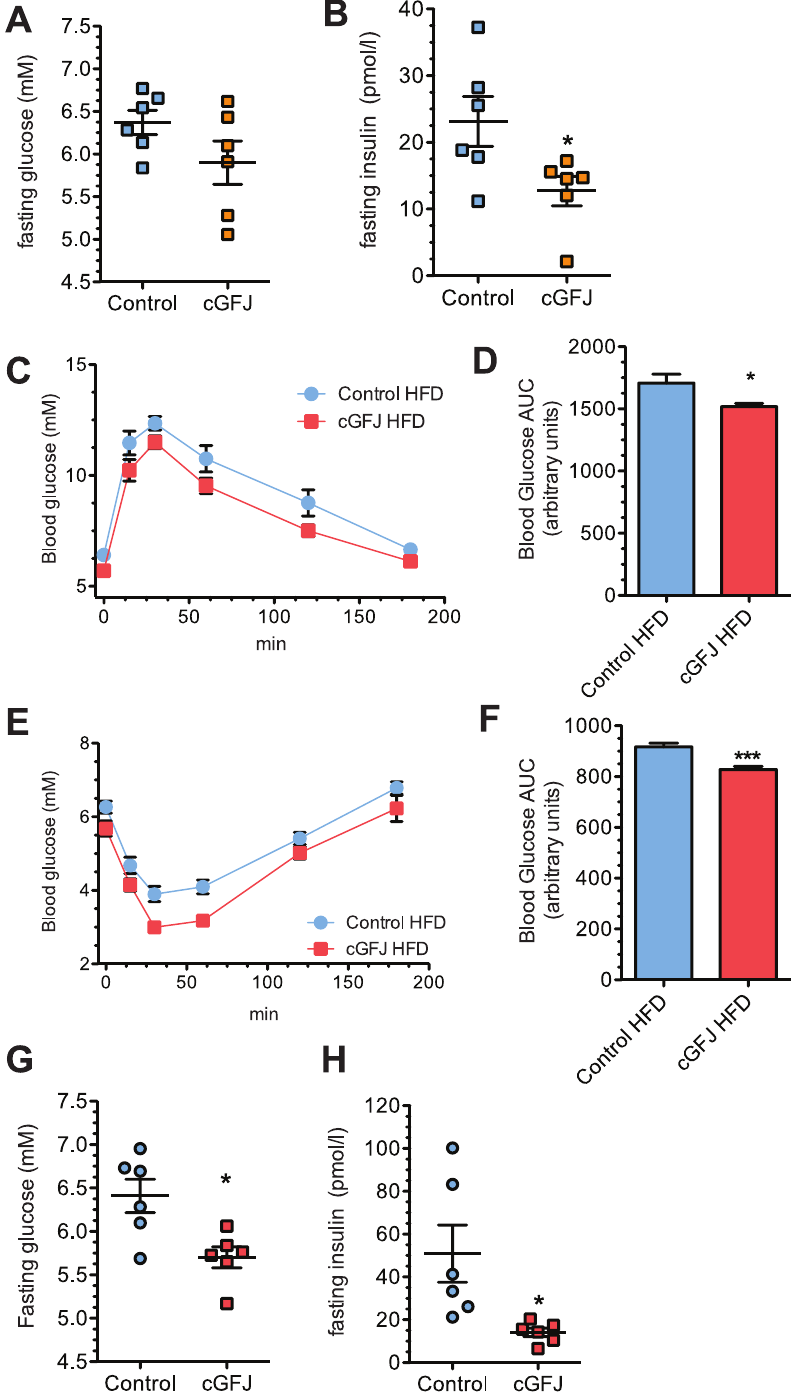
Figure 3. cGFJ effects on blood glucose and insulin sensitivity. Mice were treated as described in the legend of Fig. 2. A, B) values at the end of 100 d LFD: A, fasting blood glucose; B) fasting serum insulin, * P , 0.04; C, D) GTT and AUC of mice fed a HFD at week 13, * P , 0.04; E, F) ITT and AUC of mice fed a HFD at week 11, *** P , 0.001. G, H) Values at the end of 100 d HFD: G) fasting blood glucose, * P , 0.02; H) fasting serum insulin, * P , 0.03. A two-tailed, unpaired t-test was used to determine statistical